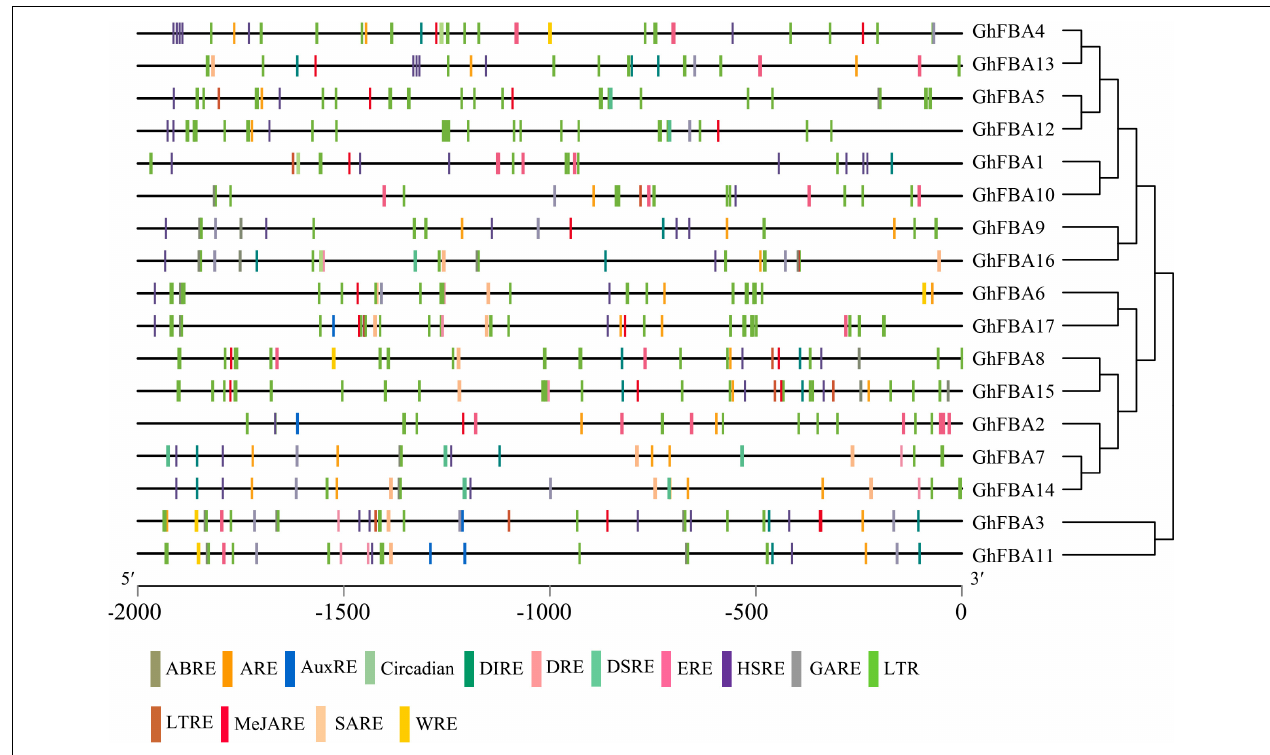
FIGURE 4 | Analysis of the responsive cis -acting elements in GhFBA genes promoter regions. The 2-kb sequences of GhFBA gene promoter regions were extracted and analyzed, and different cis -acting elements were color-coded in specific colors.